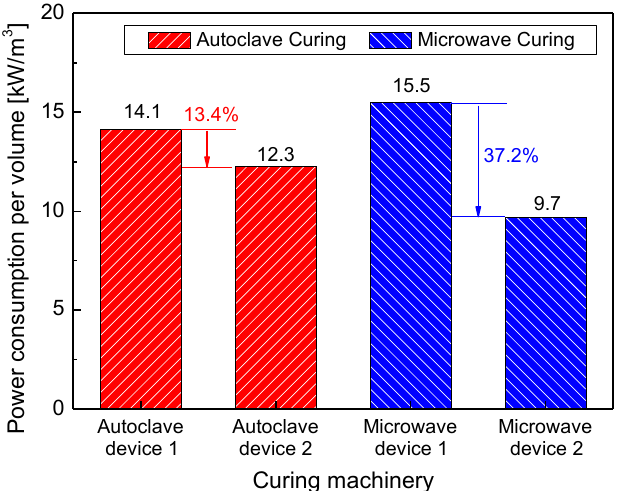
Figure 1. Comparison of power consumption in autoclave and microwave curing machinery.